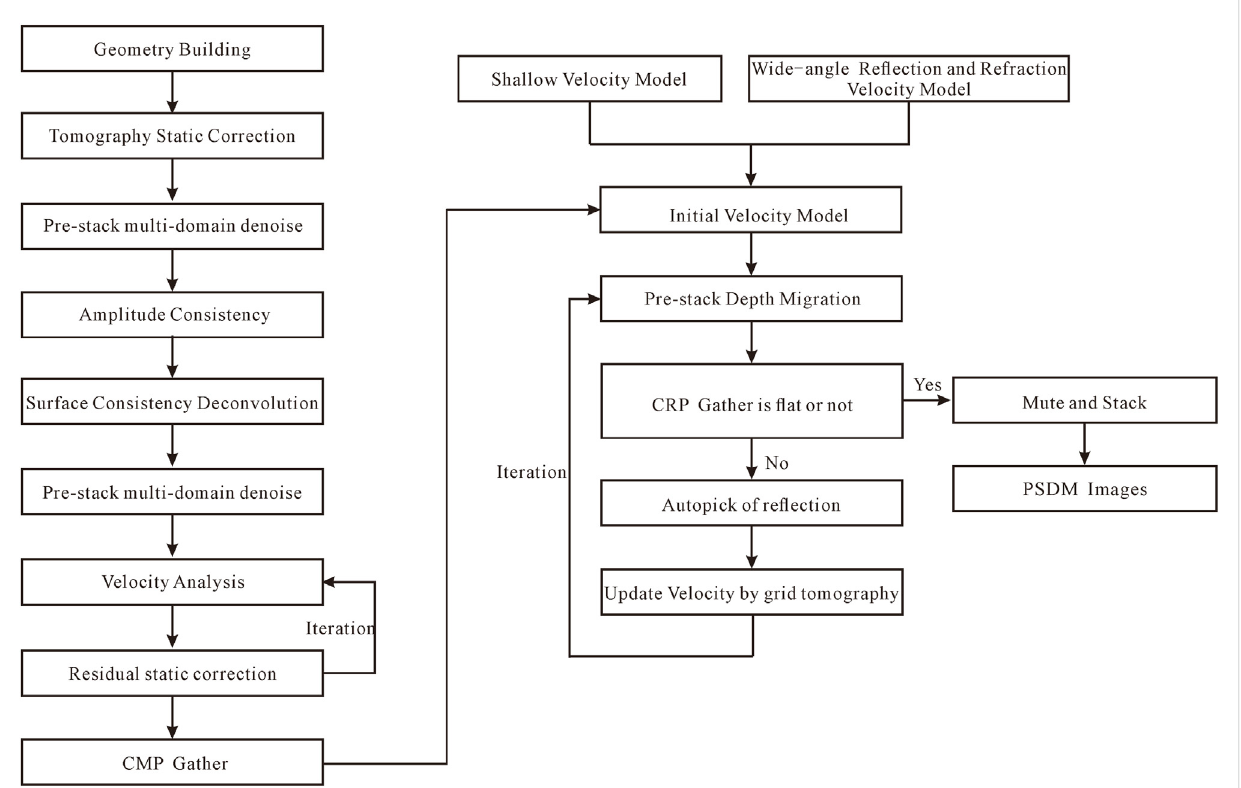
FIGURE 2 The deep seismic re fl ection data processing fl ow. The left part represents the pre-processing scheme for PSDM. The right part indicates the PSDM processing.